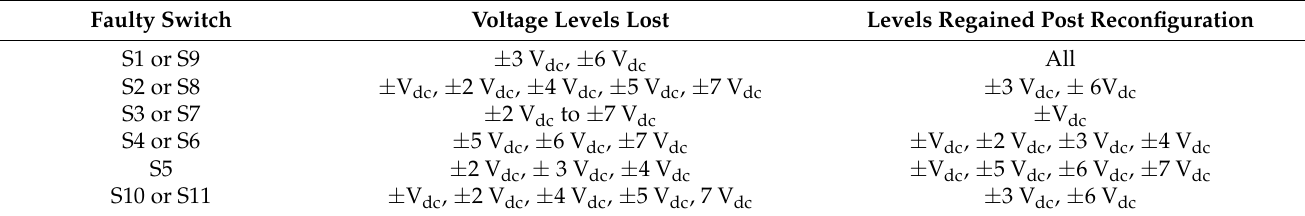
Table 2. Fault management for each switch.